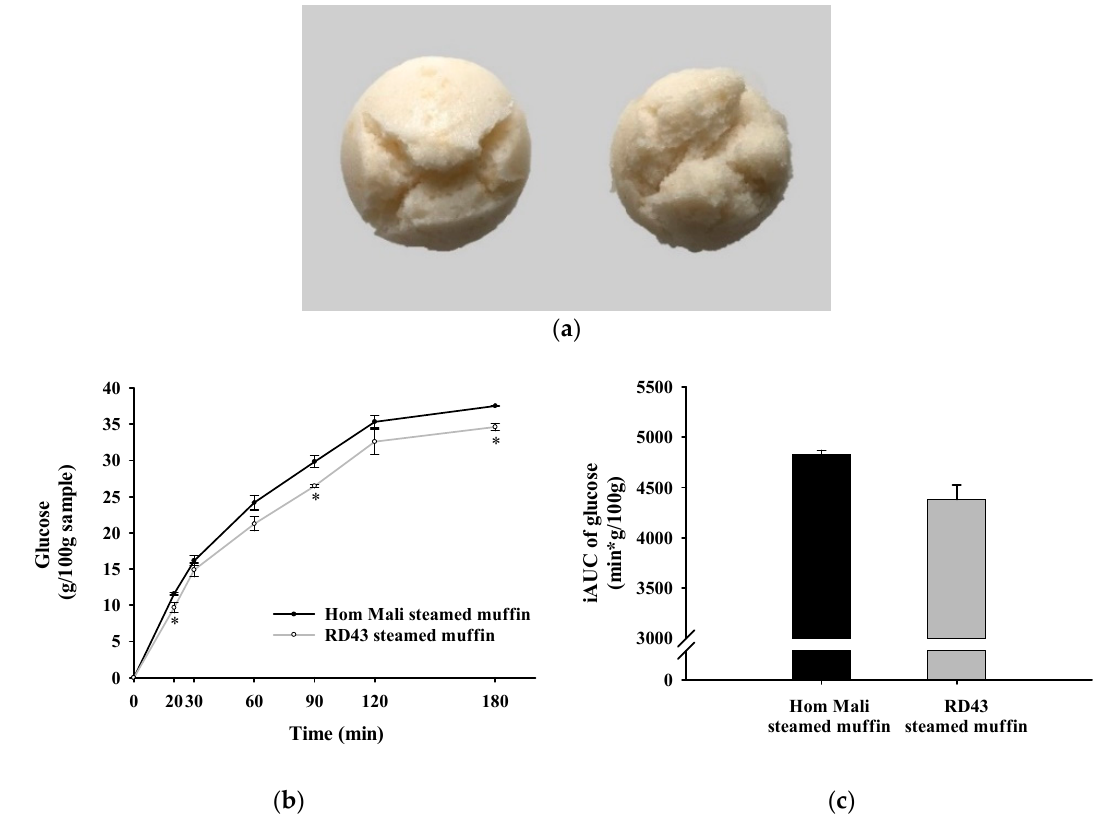
Figure 6. Photographs of ( a ) rice flour steamed muffin (left: Hom Mali steamed muffin, right: RD43 steamed muffin). ( b ) The glucose release during in vitro starch digestion from rice flour muffins, and ( c ) incremental area under the curve (iAUC) of glucose. Data are expressed as mean ± standard error of the mean, n = 3 . * p < 0 . 01 compared to Hom Mali steamed muffin.